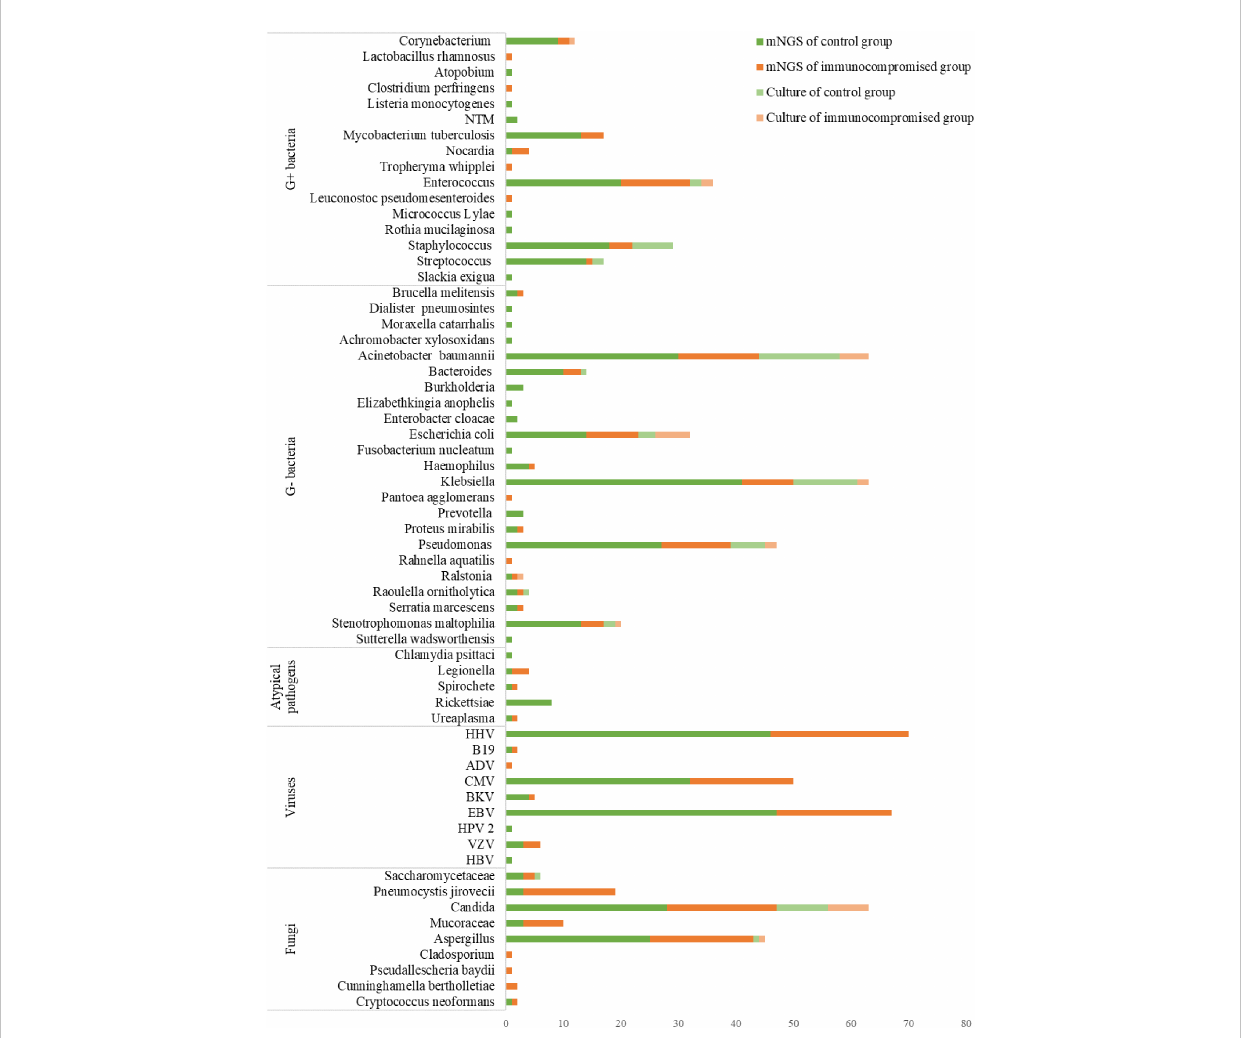
FIGURE 6 The distribution of detected pathogens of all patients by mNGS and culture method. The mNGS results were shown in dark green (control group) and orange (immunocompromised group), and the results of the culture method were shown in light green (control group) and orange (immunocompromised group). mNGS, metagenomic next-generation